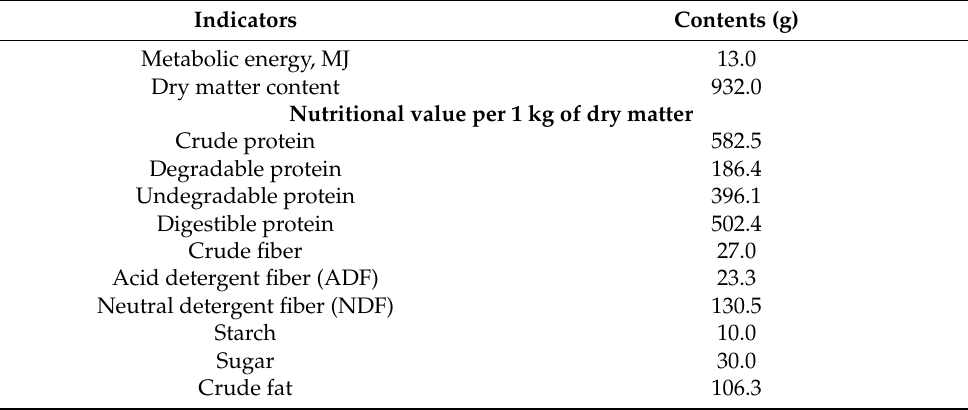
Table 2. Nutritional value of protein concentrate Agro-Matic/1 kg.